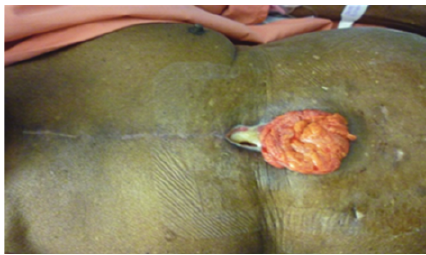
Figure 1: Shows herniated greater omentum through dehisced sternotomy wound after 10 days of VAC